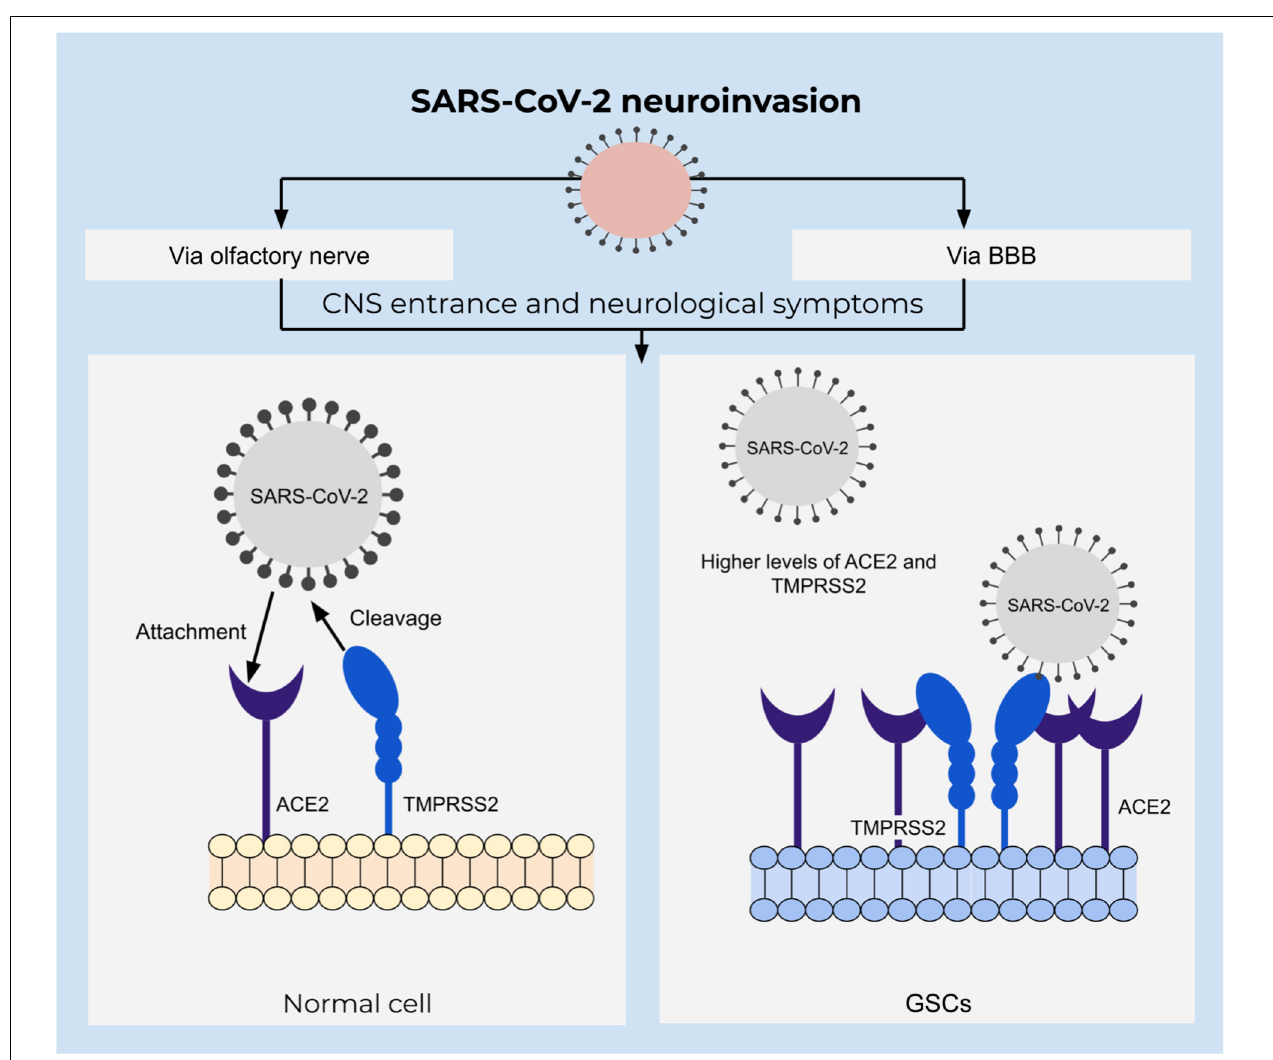
FIGURE 4 | Integrative view of neuroinvasion and glioblastoma susceptibility to SARS-CoV-2. SARS-CoV-2 entrance depends on the attachment of the spike protein to the ACE2 receptor that is mediated by TMPRSS2 in a proteolytic manner. ACE2 is upregulated in GSCs and might increase susceptibility to SARS-CoV-2